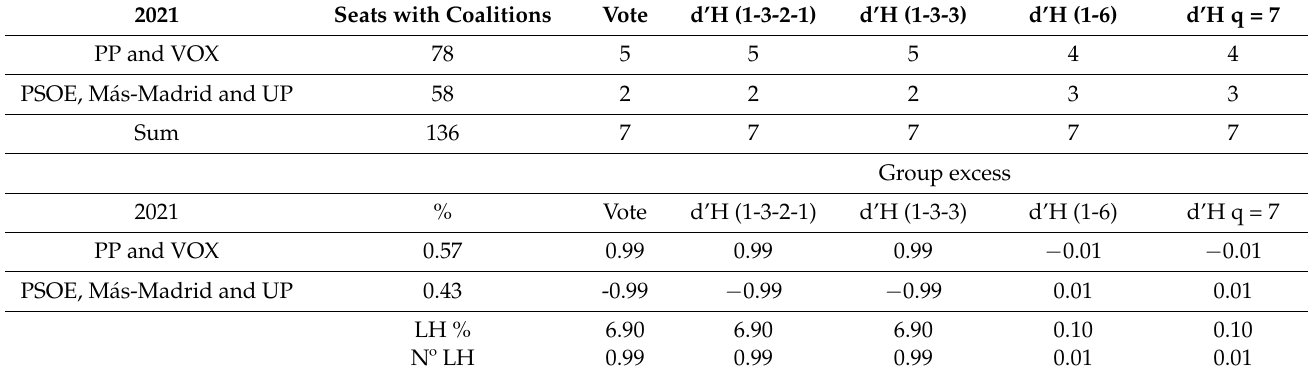
Table A1. Number of posts and the Disproportionality Index according to the number of states. 2021 Seats with